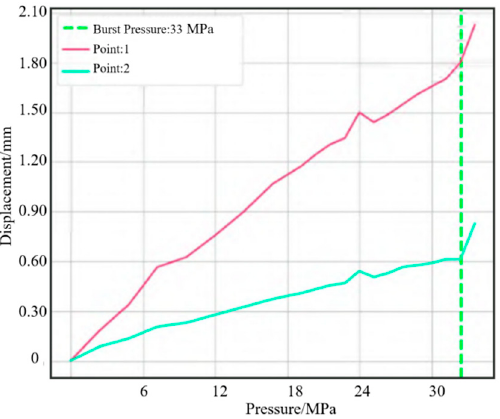
Figure 10. Tendency of displacement.